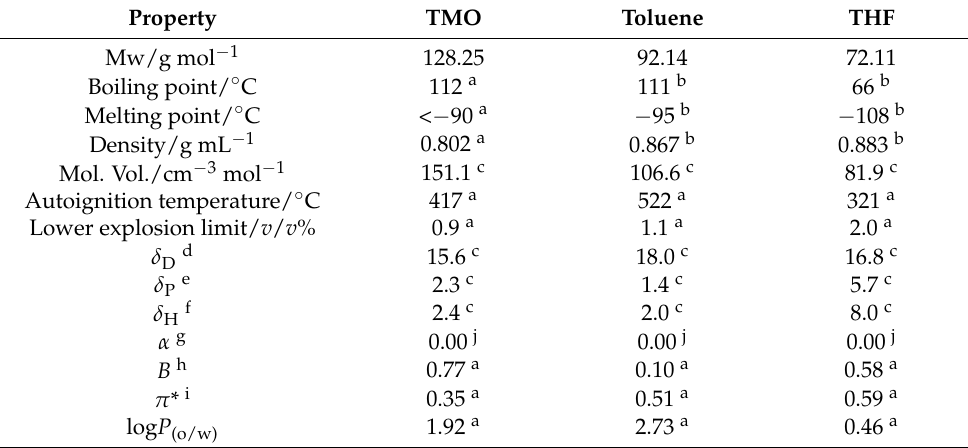
Table 1. Properties of TMO compared to toluene and THF.